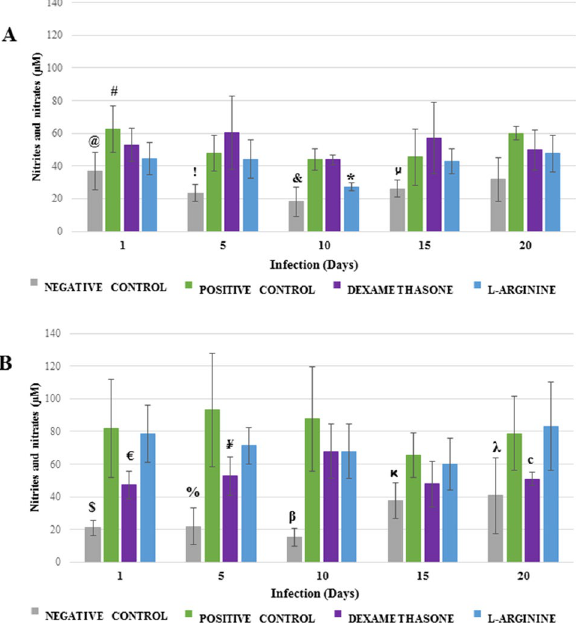
Figure 5. Nitrites and nitrates in the lungs ( A ) and brains ( B ) of Plasmodium berghei -infected Swiss mice. Animals were pretreated and received a daily dose of DEXAMETHASONE, L-ARGININE, or PBS (CONTROL). @ p < 0.0001 versus POSITIVE CONTROL and p = 0.0013 versus DEXMETHASONE; # p = 0.0005 versus L-ARGININE and p = 0.0394 versus DEXAMETHASONE; ! p = 0.0006 versus POSITIVE CONTROL and p < 0.0001 versus DEXAMETHASONE and p < 0.0001 versus L-ARGININE; & p < 0.0001 versus POSITIVE CONTROL and p < 0.0001 versus DEXAMETHASONE and p = 0.0158 versus L-ARGININE; *p = 3.1 × 10 −5 versus DEXAMETHASONE and p = 1.5 × 10 −4 versus POSITIVE CONTROL; μ p = 0.0048 versus POSITIVE CONTROL and p = 0.0003 versus DEXAMETHASONE and p = 0.0001 versus L-ARGININE; $ p < 0.0001 versus POSITIVE CONTROL and p < 0.00001 versus L-ARGININE; € p = 3.4 × 10 −6 versus L-ARGININE and p = 5.0 × 10 −4 versus CONTROL; % p < 0.00001 versus POSITIVE CONTROL and p < 0.00001 versus DEMATHASONE and p = 0.0001 versus L-ARGININE; ¥ p = 3.6 × 10 −4 versus L-ARGININE and p = 4.6 × 10 −4 versus POSITIVE CONTROL; β p = 0.0007 versus POSITIVE CONTROL, p = 0.0007 versus DEXAMETHASONE, and p = 0.0057 versus L-ARGININE; κ p = 0.0001 versus POSITIVE CONTROL and p = 0.0015 versus L-ARGININE; λ p = 0.0094 versus L-ARGININE; c p = 0.0058 versus L-ARGININE and p = 0.0201 versus POSITIVE